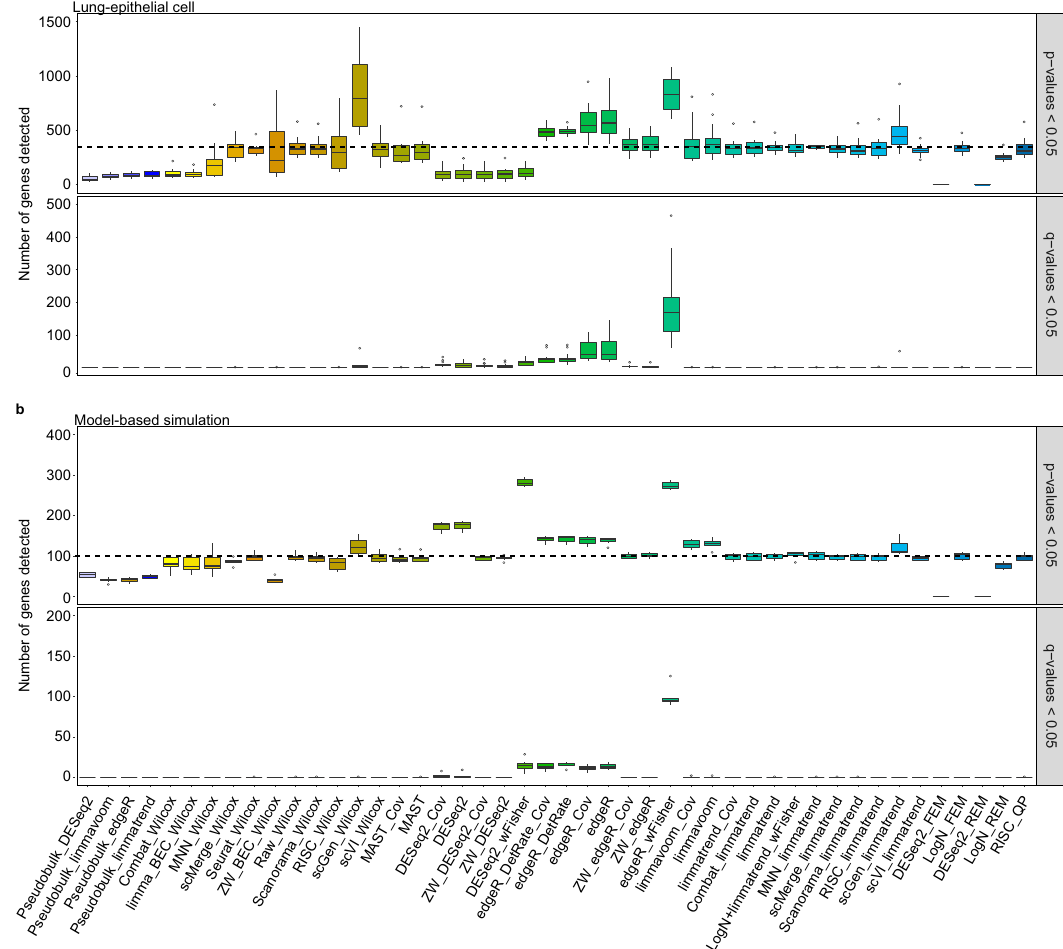
the lower, center, and upper bars represent the 25th, 50th and 75th percentiles, respectively, and the whiskers represent ±1.5×interquartile range. Black dashes indicatethe fi vepercentofallgenestested. n =2331and2400cellswereusedfrom normal lung epithelial cells and model-based